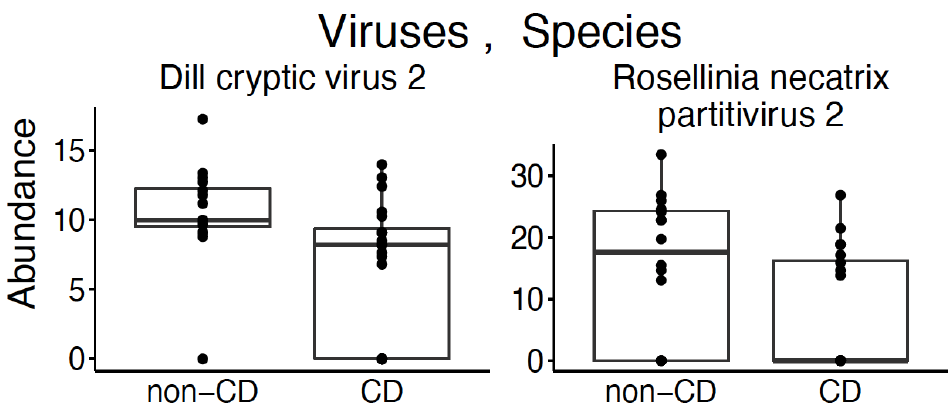
Figure 3. Cross-sectional analysis of viral species in the breast milk of subjects with CD on a gluten- free diet compared with healthy controls. Viral species with a statistically significant difference in abundance between the breast milk of subjects with CD on a gluten-free diet and healthy controls according to Mann–Whitney U test (Wilcoxon rank-sum test) ( p -value < 0.05).